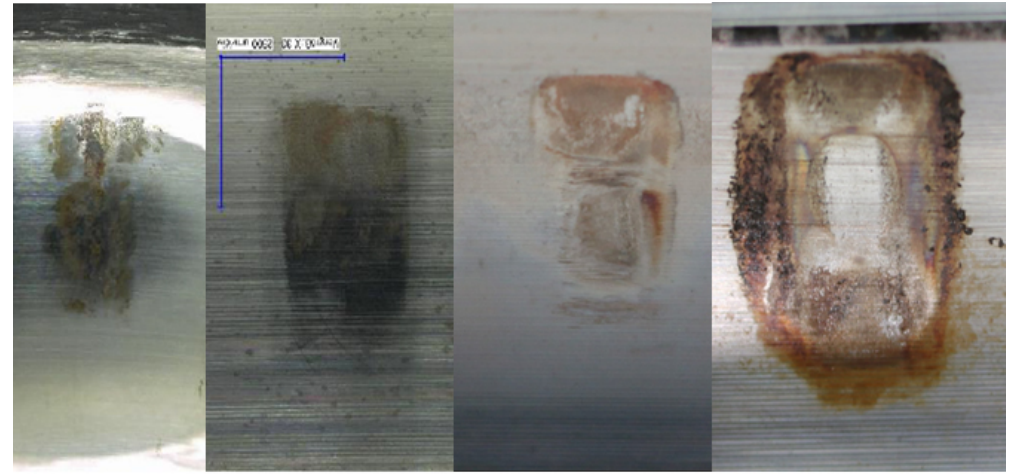
Figure 12. Wear with similar x/ 2 b on bearings ranging from 80 to 5000mm outer diameter (Schwack, 2020; Stammler, 2020).